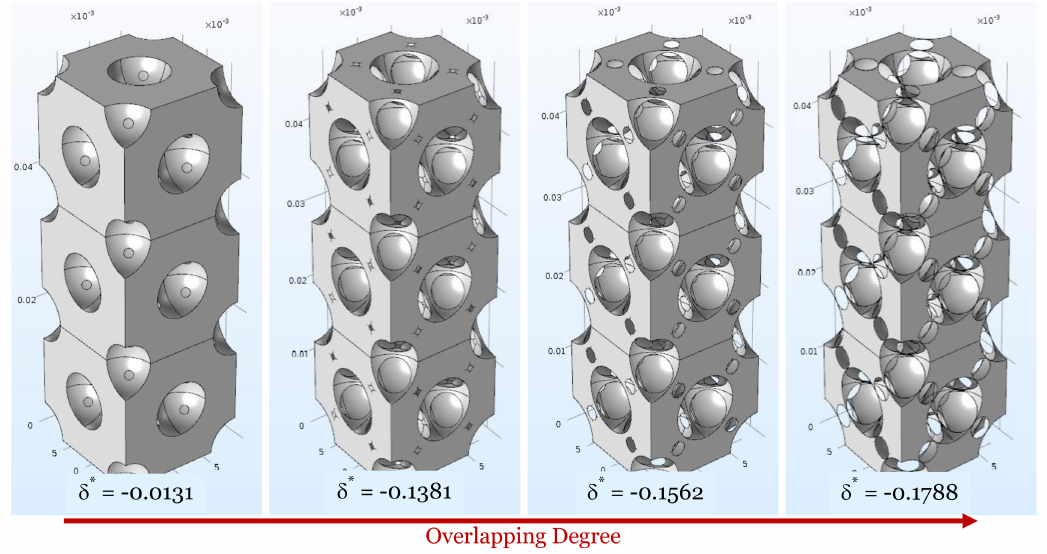
Figure 6. Morphology evolution of the Tetragonal structure with increasing overlapping